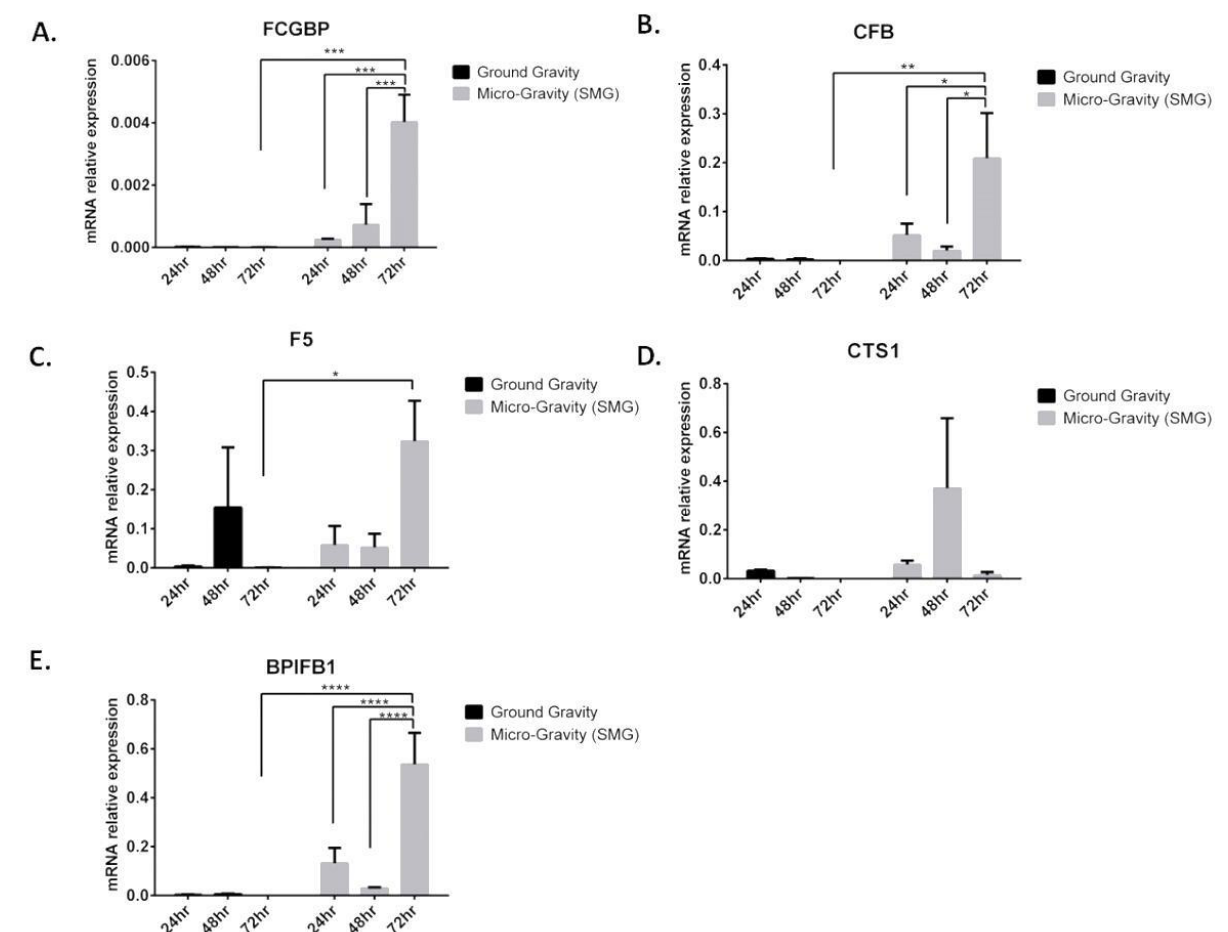
Figure 4. Upregulation of FCGBP , CST1 , F5 , CFB , and BPIFB1 under SMG condition in vitro. mRNA expression levels of ( A ) FCGBP , ( B ) CFB , ( C ) F5 , ( D ) CTS1 , and ( E ) BPIFB1 , quantified by qRT-PCR and normalized to GAPDH in A549 cells subjected to GG and SMG conditions for 24, 48, and 72 h. Bar graphs display results of 3 independent experiments ( n = 3). * p < 0.05, ** p < 0.01, *** p < 0.001, and **** p < 0.0001.